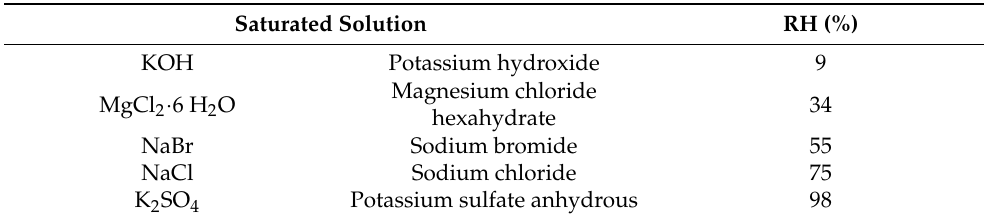
Table 1. Saturated solution of chemicals used to obtain appropriate relative humidity